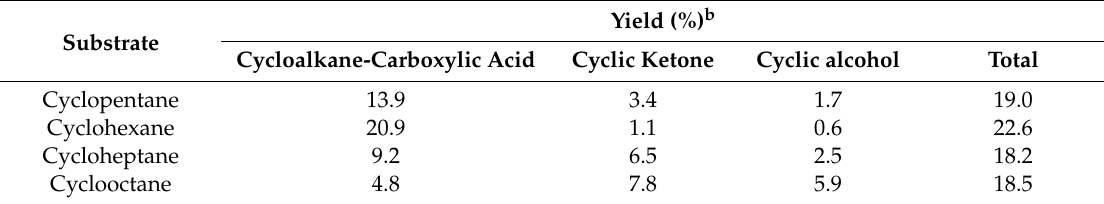
Table 3. Single-pot carboxylation of cycloalkanes catalyzed by 1 a .